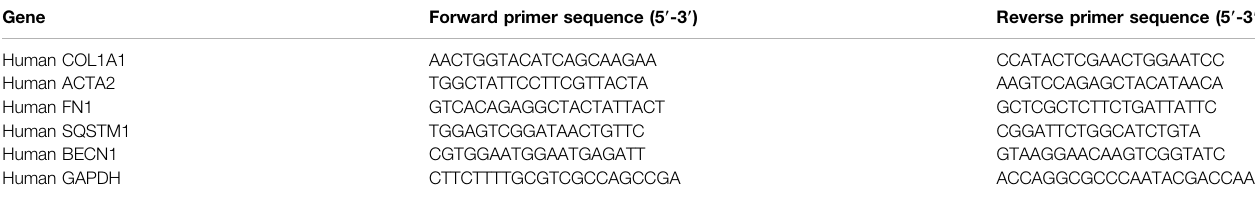
TABLE 1 | mRNA primer sequences for